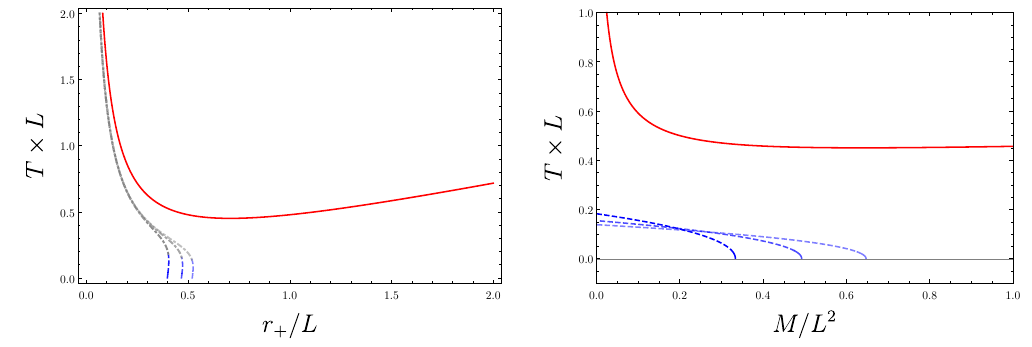
Figure 6 . Properties of five-dimensional uncharged black holes II . Here we show plots of the temperature vs. horizon radius and temperature vs. mass for µ = 0 (red) and µ/µ (blue/gray curves; left to right). Each non-zero value of µ here is larger in magnitude than the special value of µ = 79 L 4 / 1890 which marks the point at which the large black holes no longer − exist. The dashed blue curves indicate negative Wald entropy, while the dot-dashed grey curves indicate that the mass is negative — these solutions do not exist. Note that for small temperatures the entropy is